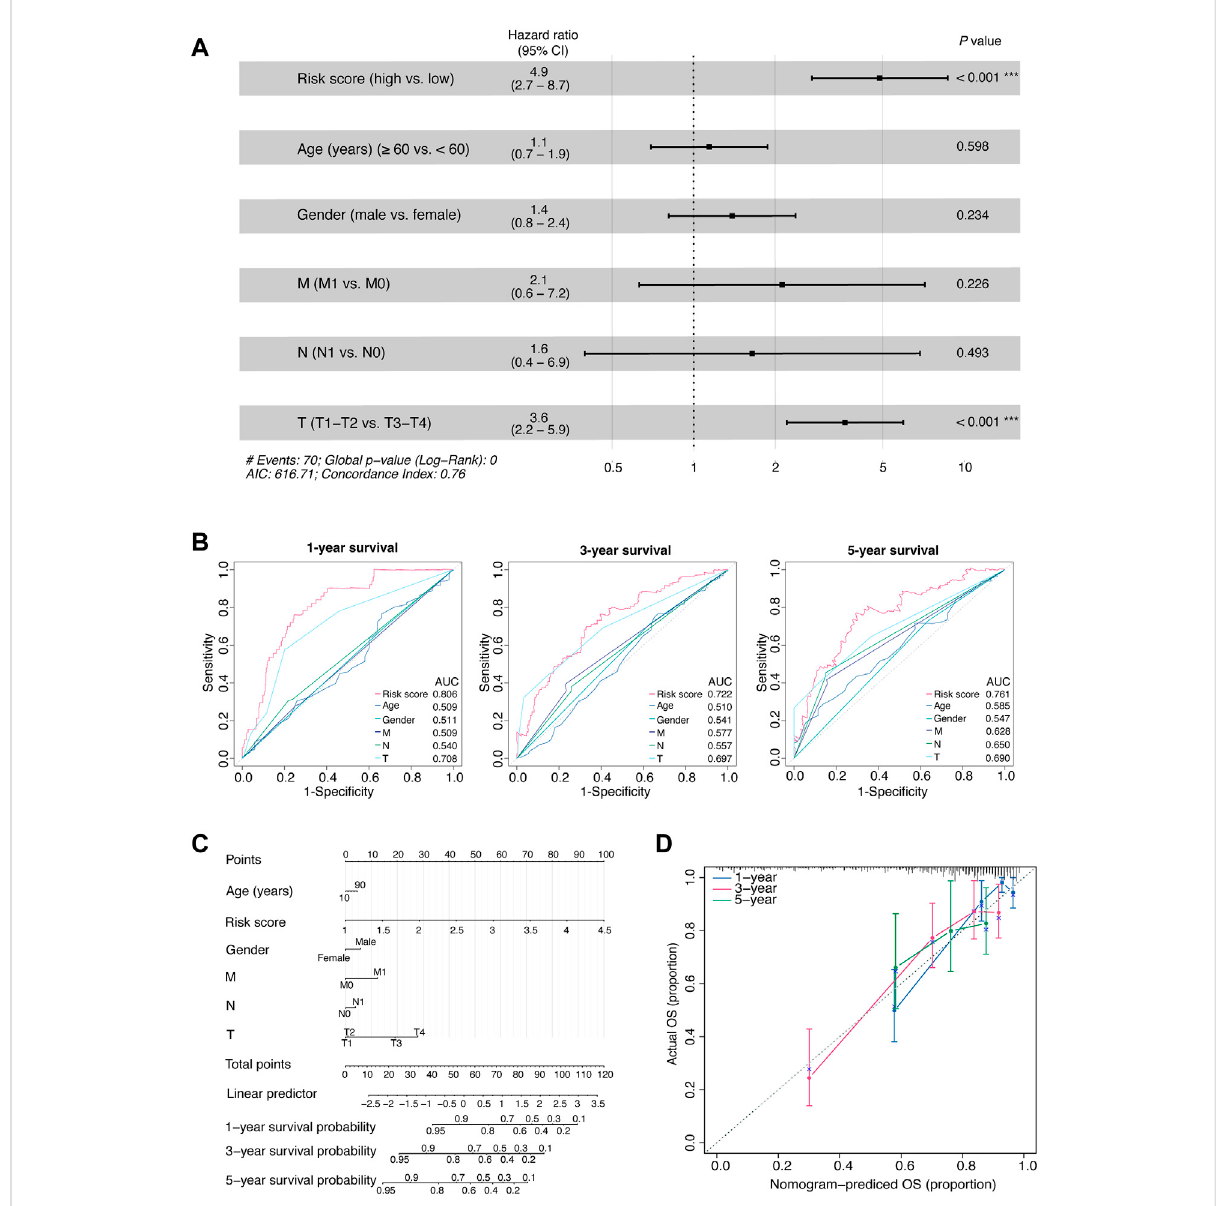
FIGURE 3 Comprehensiveassessmentoftheprognostic model. (A) The HRswith 95% CIs,and p values oftheriskscore and clinicalfactorsdetermined by multivariate Cox regression analyses. (B) Time-dependent AUCs of the risk score and clinical factors based on the ROC curves for predicting 1-, 3-, and5-yearsurvival(includingage,gender,Mstage,Nstage,andTstage). (C) Anintegratednomogramforpredictingthepossibilitiesof1-year,3-year and 5-year survival for TCGA-LIHC cohort. The prognostic nomogram was constructed using the risk score from the 11-OIS-related-lncRNA prognostic risk model and clinical factors. (D) Calibration curvesof theconcordance betweenthe predictedand observed 1-, 3-, and 5-year survival ratesofHCCpatients fromtheTCGAcohortbasedontheprognosticnomogram.Nomogram-predicted OS isplotted onthex-axis;theactualOSis plotted on the y-axis. The diagonal dotted line represents a perfect prediction by an ideal model. OIS, oncogene-induced senescence; HR, hazards ratio; CI, con fi dence interval; AUC, area under the curve; ROC, receiver operating characteristic; T, tumor; N, node; M, metastasis; HCC, hepatocellular carcinoma; TCGA, the cancer genome atlas; OS, overall